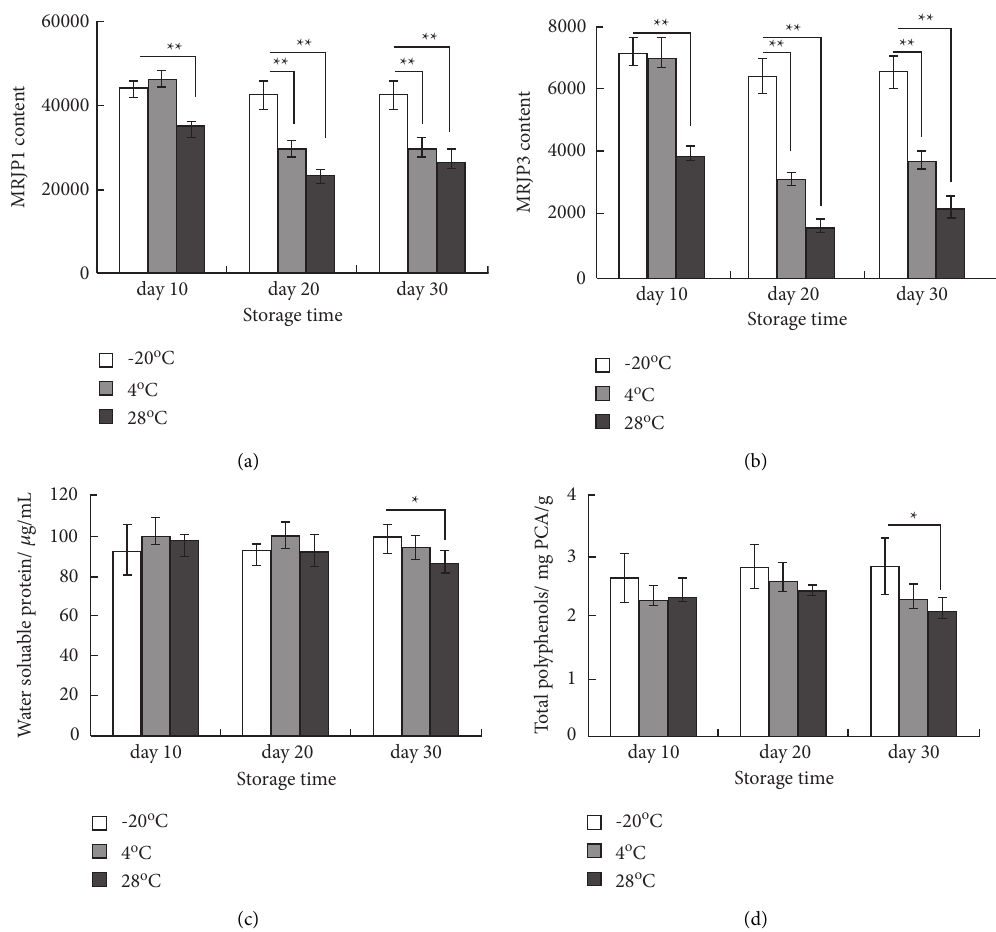
Figure 6: (a) Effect of temperature on the MRJP1; (b) effect of temperature on the contents of MRJP3; (c) effect of temperature on the contents of water-soluble protein; (d) effect of temperature on the contents of total polyphenols. ∗ means statistical difference level for p < 0 . 05 and ∗∗ means statistical difference level for p < 0 . 01 when compared to samples stored at − 20 °